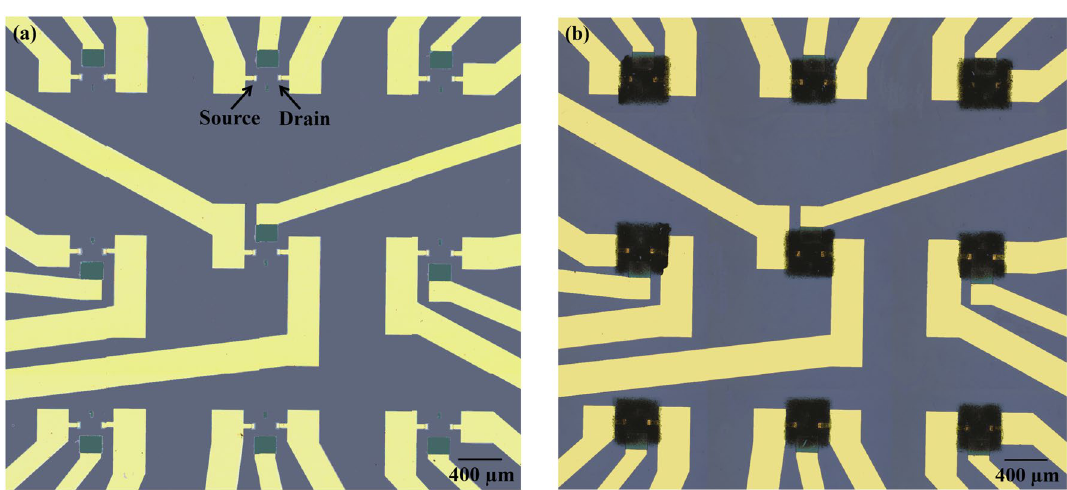
Figure 3. The snapshots of diced s-SWNTs chip with source-drain electrodes in 3 × 3 array of devices, ( a ) before and, ( b ) after s-SWNTs